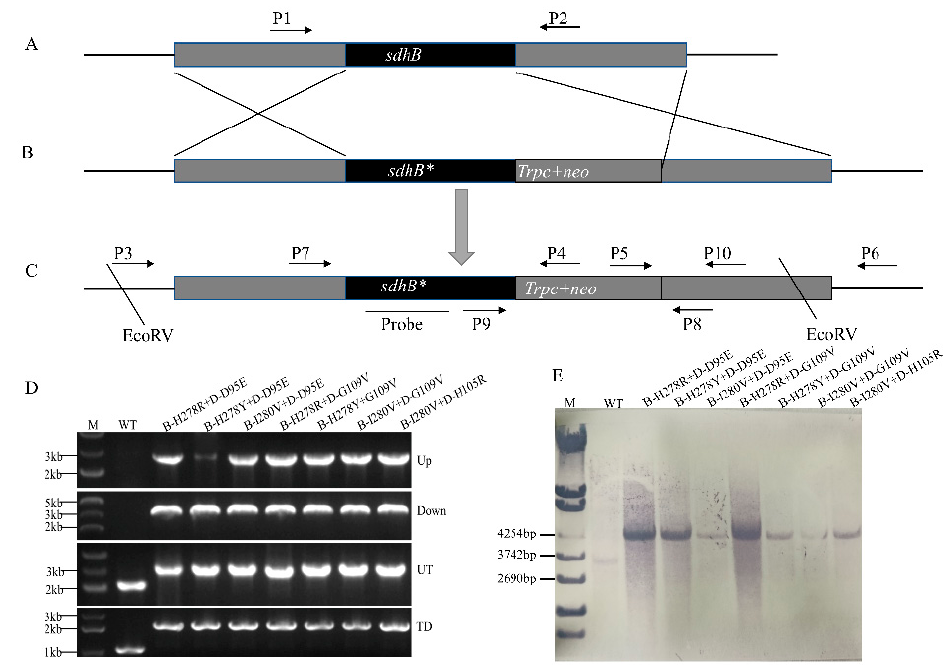
Figure 1. Generation and identification of C. cassiicola SDHB gene replacement mutants. ( A – C ) Sche- matic representation of the gene replacement strategy. The double mutations were obtained by gene substitution of a single point mutation (resistant mutants caused by a single point mutation in the SDHD gene, including D-D95E, D-H105R, and D-G109V) as the parent strain. ( A ) The SDHB target of the resistant mutants containing a point mutation in the SDHD gene. ( B ) The gene replacement vector was constructed by double-joint PCR. The two gray fragments represent the left and right homologous arms of the SDHB gene. The black fragment represents the target SDHB gene. The middle part represents the gene replacement cassette ( SDHB * + Trpc + neo ) connecting the left and right homologous arms of SDHB . ( C ) Mutants carrying the double mutation. ( D ) PCR assay to verify the integration of the replacement cassette at the left connection ( Up ), and right connection ( Down ) points. PCR was also performed to indicate homozygosity of the replacement cassette at the left connection ( UT ) and right connection ( TD ) points. (E) Southern blot hybridization analysis of WT transformants using an 858-bp fragment from the SDHB gene as a probe. Genomic DNA was di- gested with EcoRV at the SDHB gene.